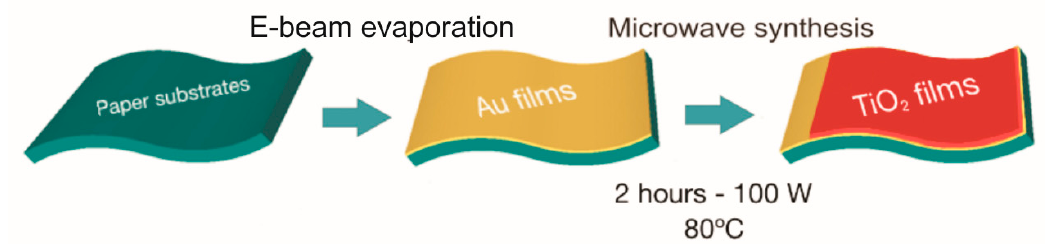
Figure 1. Scheme of the gold layer deposition followed by the titanium dioxide (TiO 2 ) nanostructured film growth under microwave irradiation.